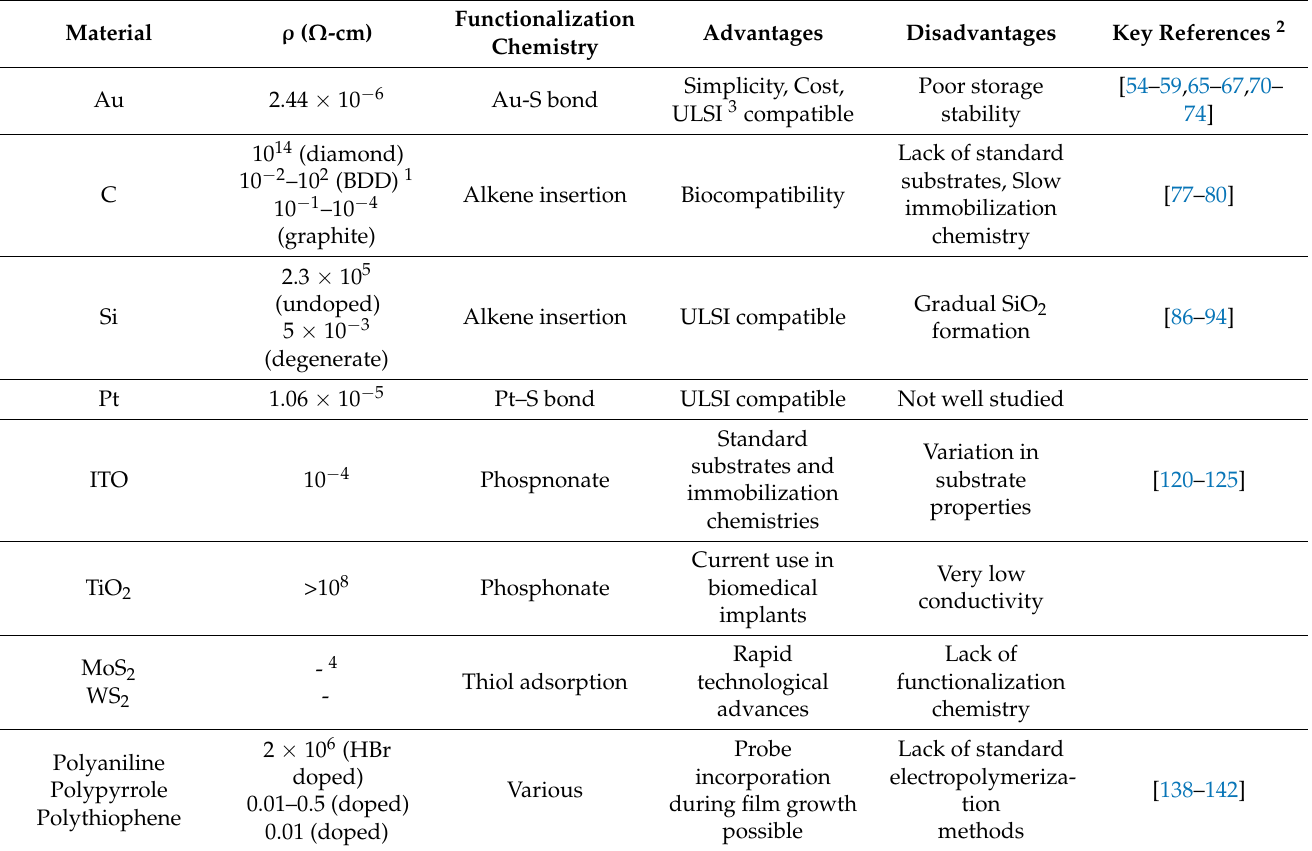
Table 1. Properties of different electrode substrate materials that have been